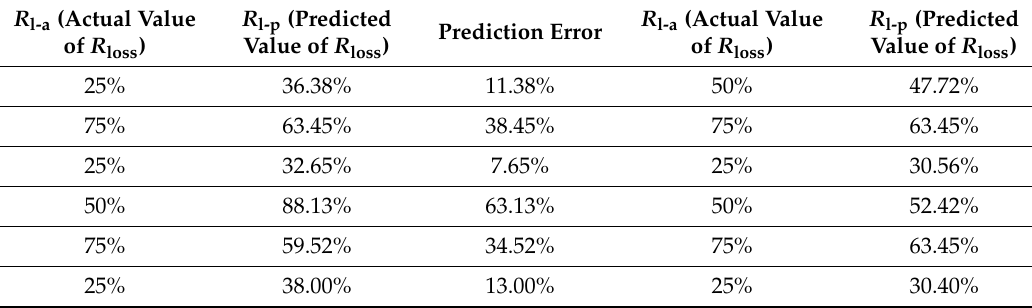
Table 10. Comparison of the estimated and actual values (using the univariate V ce ).